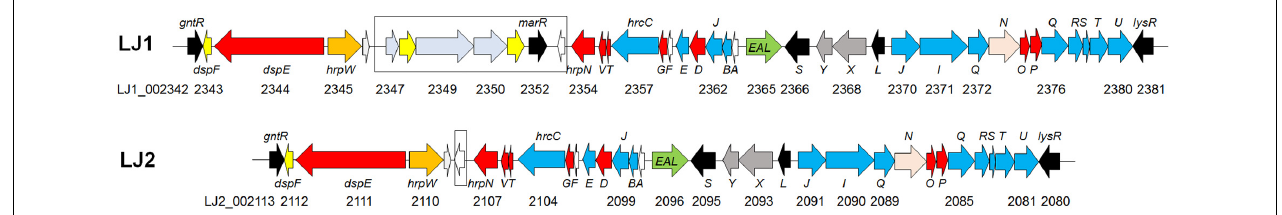
FIGURE 5 | Gene arrangements of T3SS in the genomes of Pectobacterium colocasium sp. nov. LJ1 and Pectobacterium aroidearum LJ2. Genes are plotted as arrows in the order of their genomic positions in the T3SS gene cluster. The direction of each arrow indicates the gene coding strand, and the length of each arrow is in proportion to the size of the gene. Arrows in the colors of yellow, red, blue, black, and pink correspond to genes encoding molecular chaperones, effectors, structural proteins, regulators, and ATPase, respectively. The black box highlights the fimbrial gene cluster insertion in the T3SS of